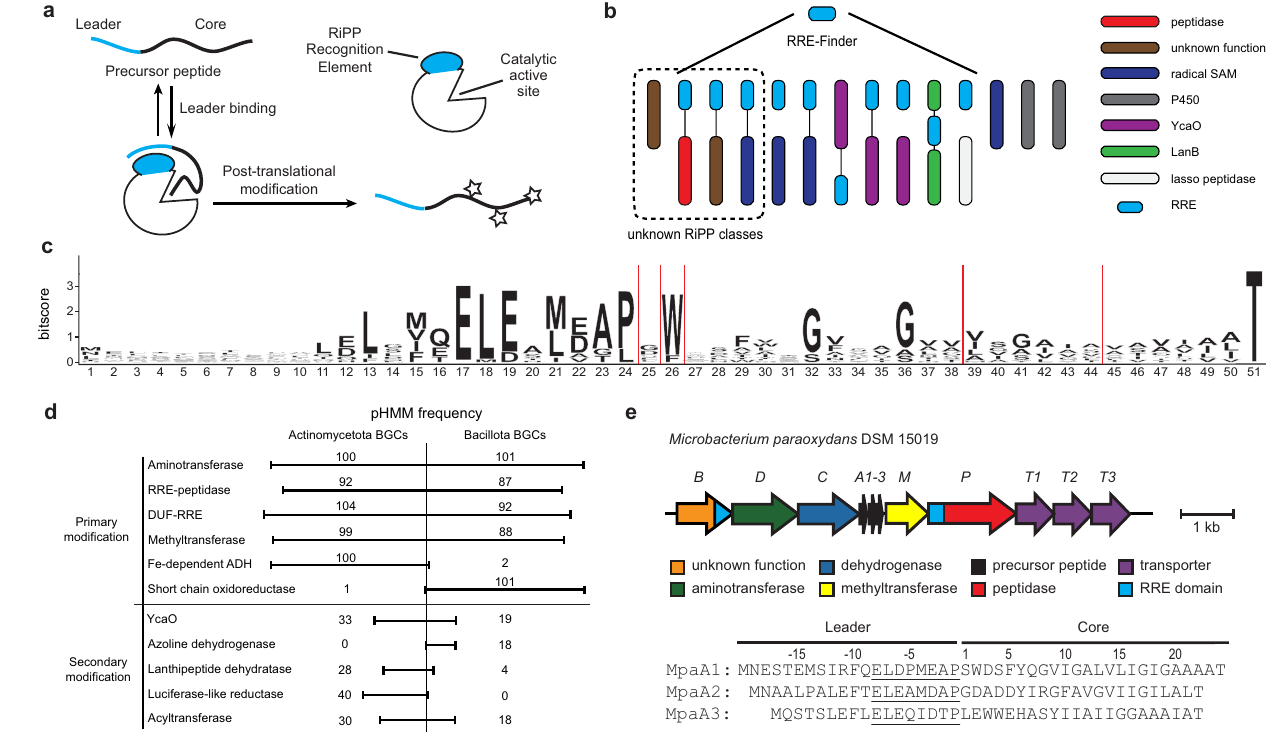
Fig. 1 | RRE-based discovery of a RiPP class. a General RRE-dependent RiPP bio- syntheticpathway. b StylizeddepictionforuseofRRE-FindertodiscoverRiPPBGCs independentofknownRiPPchemistry. c Daptideprecursorpeptidesequencelogo ( n =184). d Frequency of common pHMM hits in daptide BGCs. Common best hit pHMMs were counted and grouped as follows: Aminotransferase – PF00202, TIGR00508, TIGR00707; RRE-peptidase – PF02163, Actino_DapP_RRE, Bacill_- DapP_RRE; DUF-RRE – Actino_DapB_RRE, Bacill_DapB_RRE; Methyltransferase –